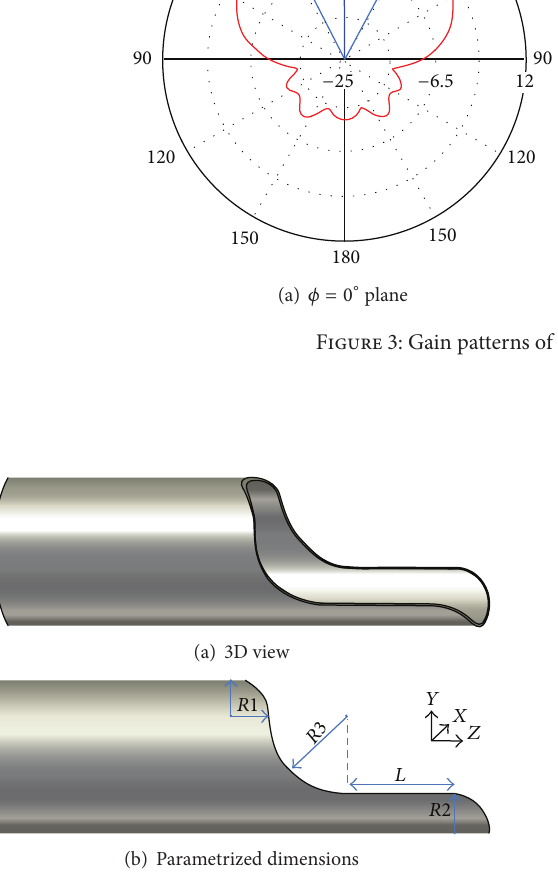
Figure 4: Vlasov antenna with proposed